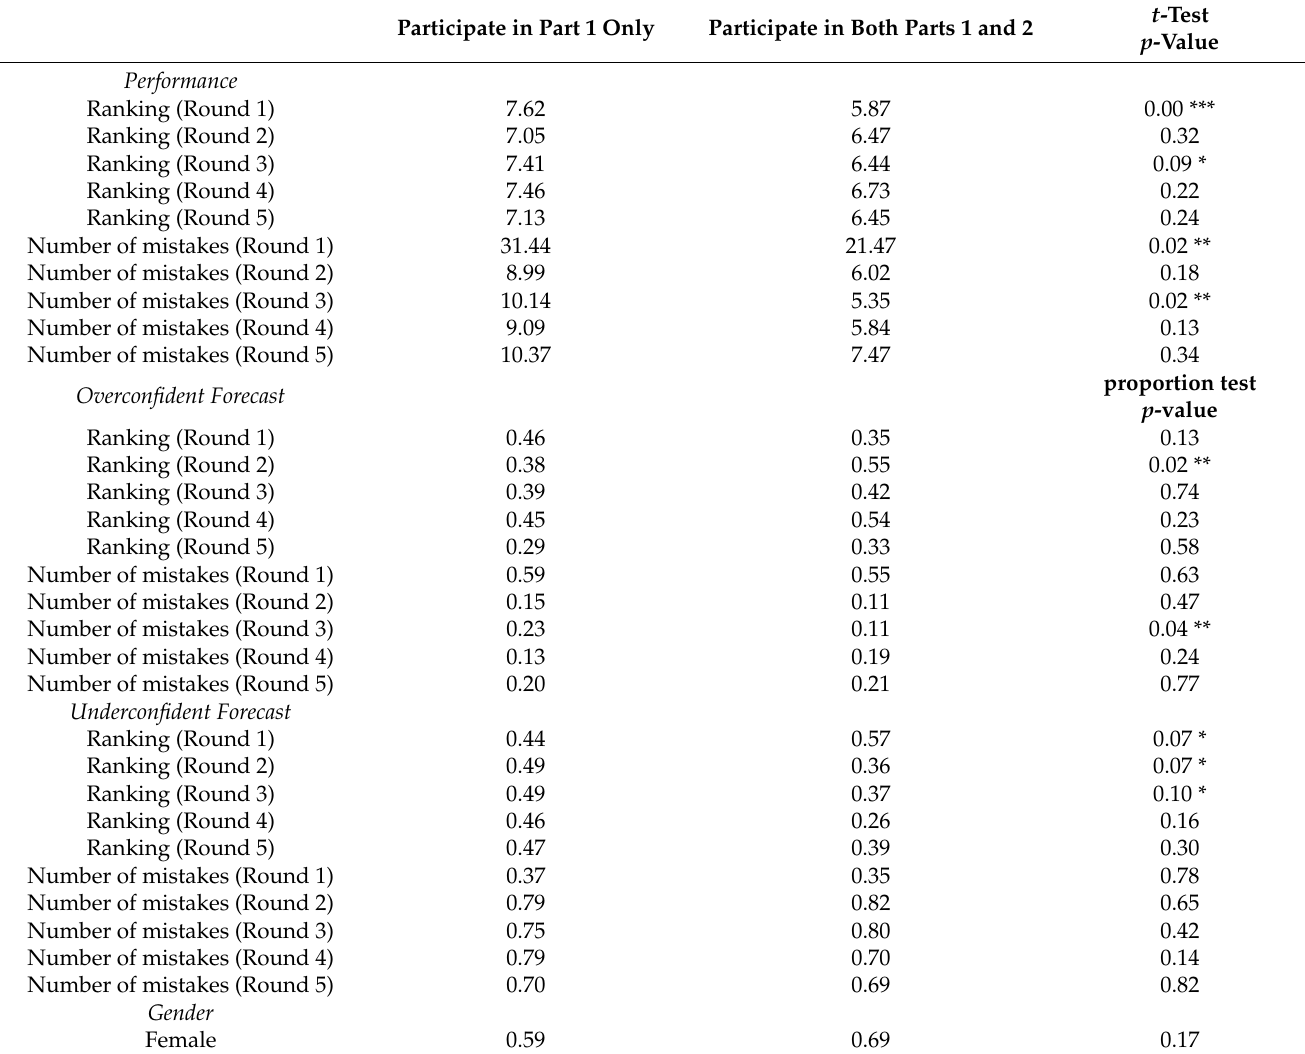
Table A1. Comparisons on Main Variables between Subjects Who Participate in Part 1 Only and Those Who Participate in Both Parts 1 and 2.